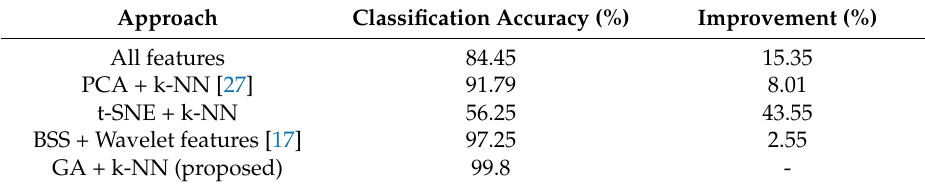
Table 4. Classification accuracy among different